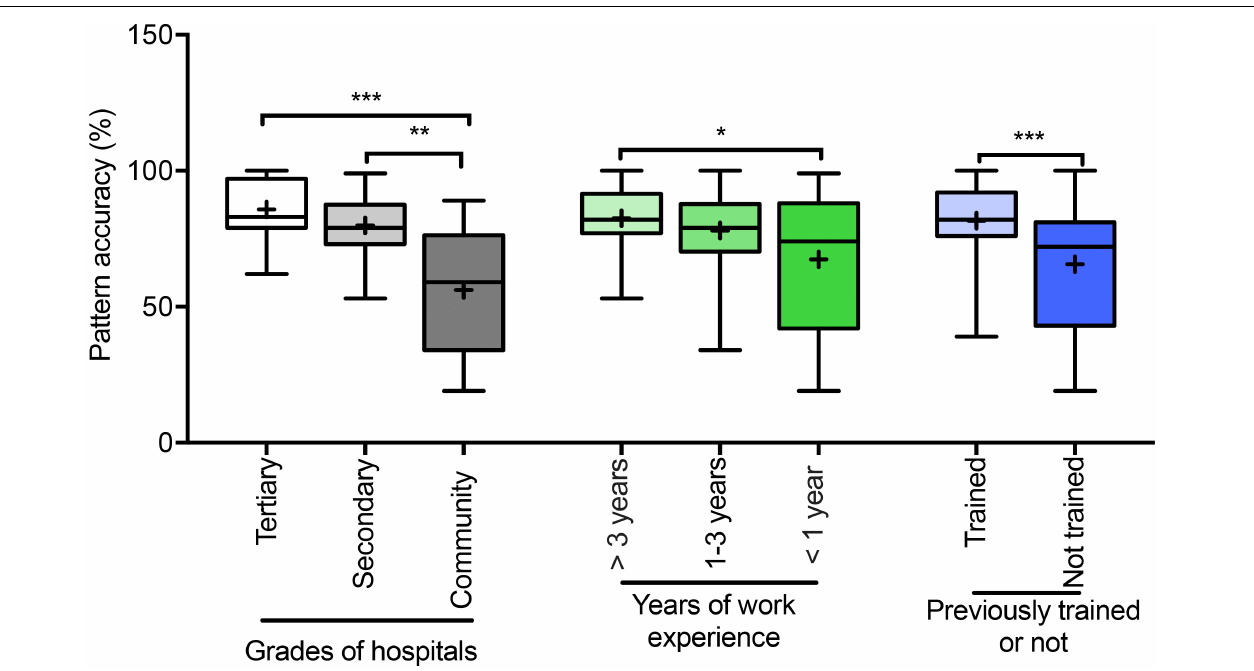
FIGURE 4 | Accuracy (%) of ventilatory pattern evaluations of physicians. Accuracy (%) of pattern evaluations of physicians belong to different grades of hospitals; different years of work experience, and presence/absence training. Box-and-whisker plots show median with interquartile range (box) and range (whiskers); the mean is indicated by “+”; * P < 0.05, ** P < 0.001, *** P < 0.0001.